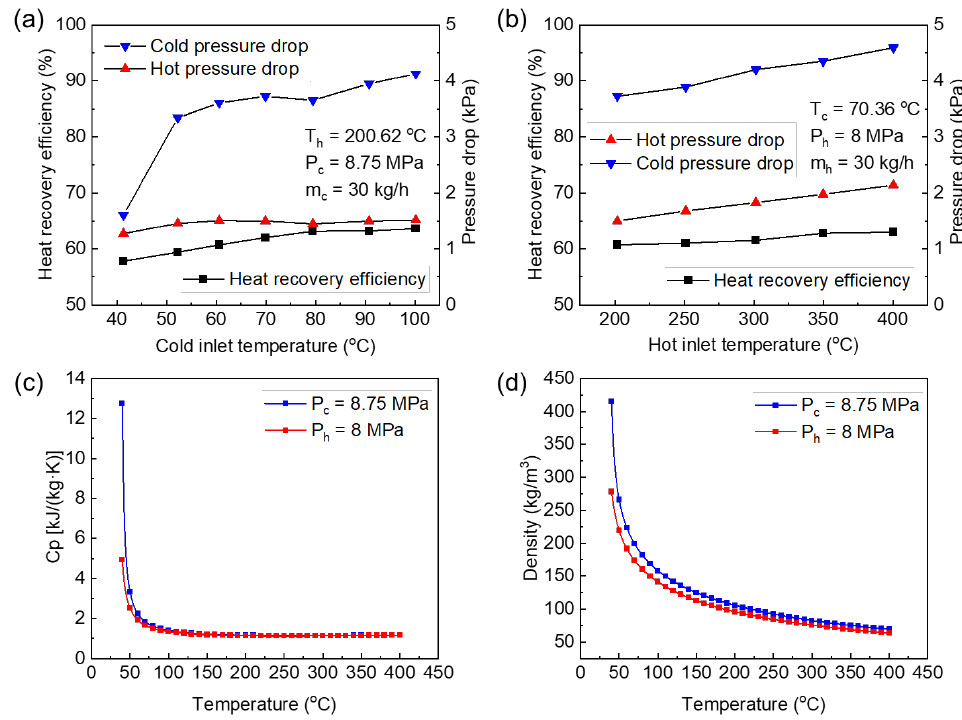
Figure 7. The effects of ( a ) the cold inlet temperature and ( b ) the hot inlet temperature on the efficiency